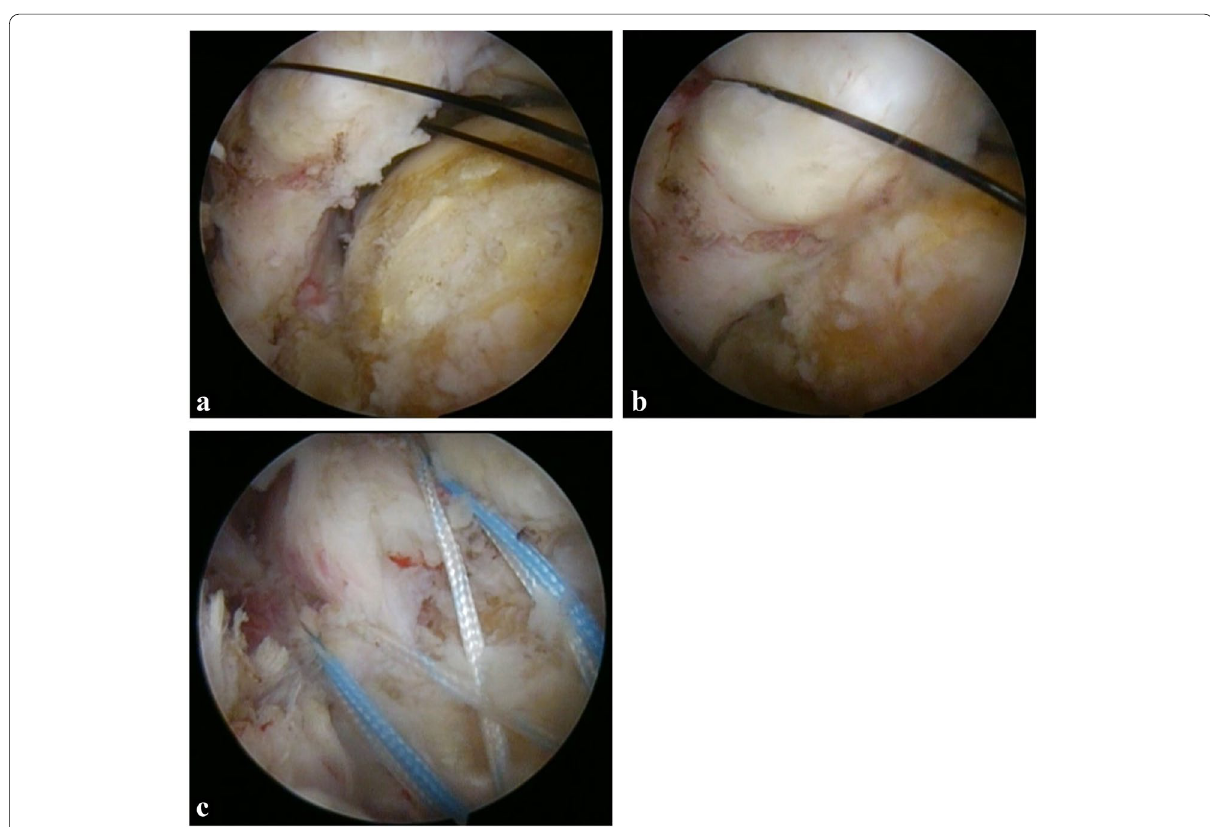
Fig. 3 Intraoperative images of the torn cuff. a Before pulling the nylon thread. b After pulling the nylon thread using a tension of 30 N. c After repairing the torn cuff using a suture bridge. When full coverage of the footprint is possible with a tension of (ARCR) is performed using the suture bridge technique